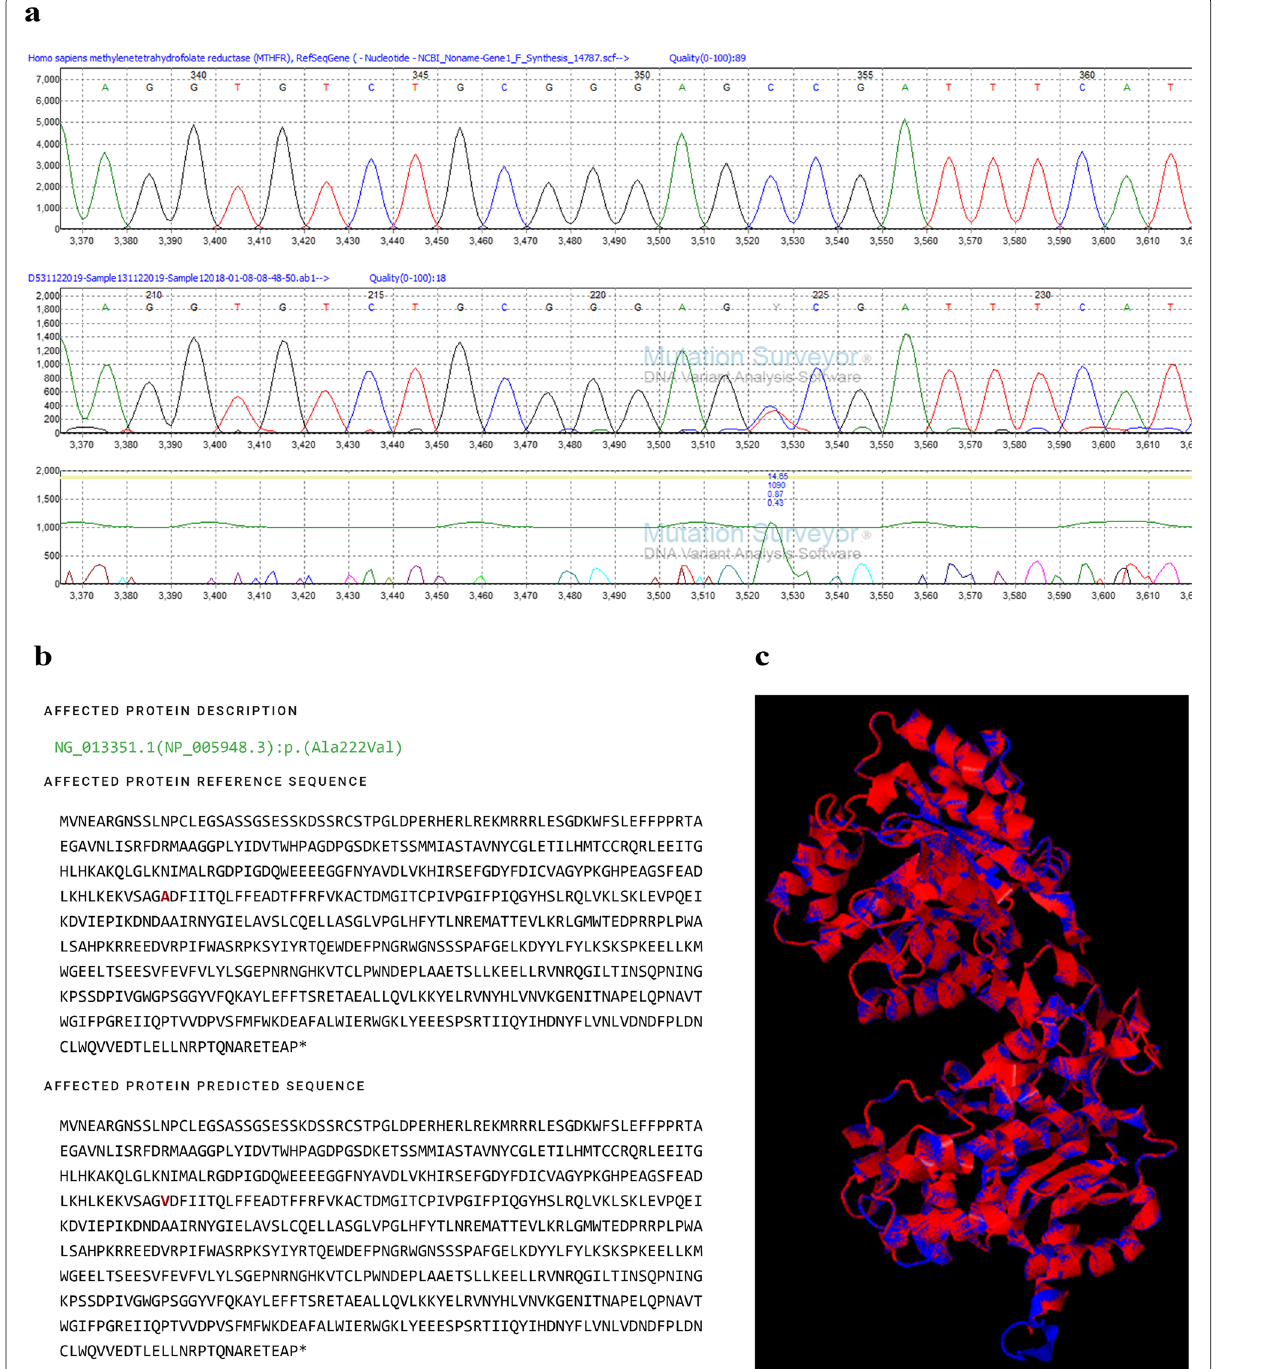
Fig. 2 Reported missense variant, c.665C>T in MTHFR (p. Ala222Val), in exon 5. a Mutation Surveyor ® V4.0.10 images indicating the heterozygous substitution point; respect to the reference MTHFR sequence and the study sample MTHFR sequence. b Protein prediction using Mutalyzer 3. c Superimposed image of predicted mutated protein with wild-type CBS protein (P42898 MTHFR_HUMAN), red indicates the mutated protein; blue indicates the wild-type